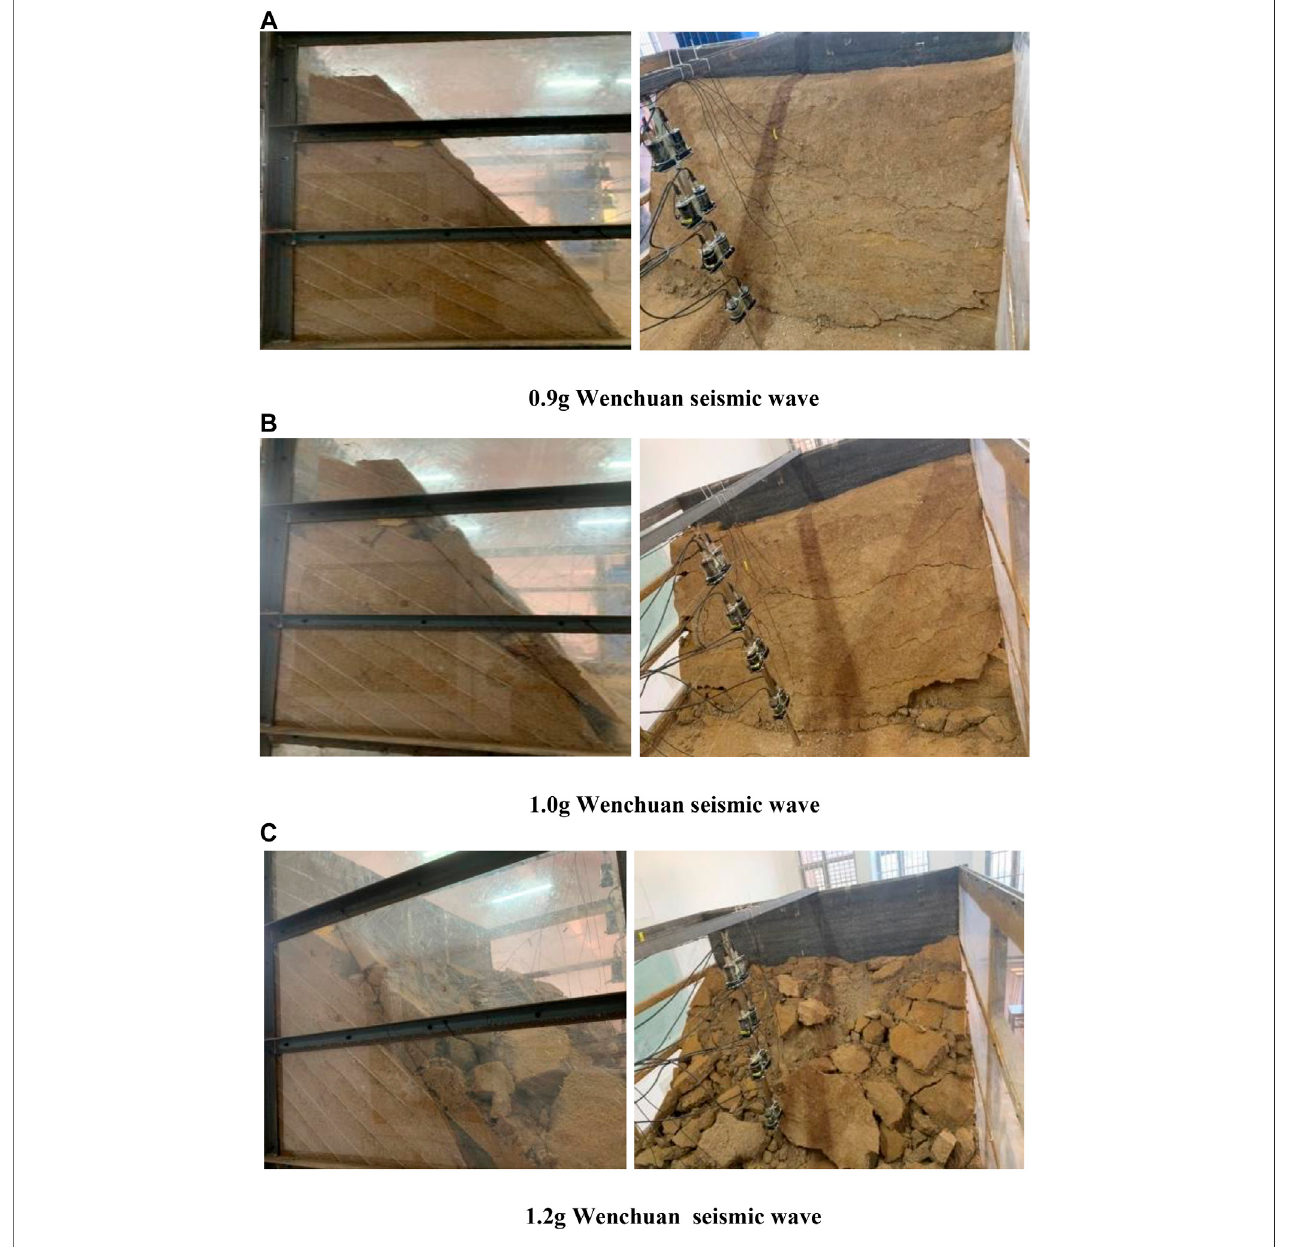
FIGURE 12 | The instability process of bedding rock slope. (A) 0.9 g Wenchuan seismic wave. (B) 1.0 g Wenchuan seismic wave. (C) 1.2 g Wenchuan seismic